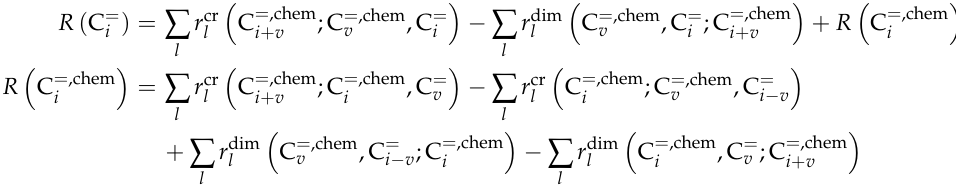
Scheme 14. Net rates of production of the different species for the model by von Aretin et al. [164] with i ranging from 2 to 12 for R and for R ; the same rules as in Scheme 13 apply for the different indices of the reaction